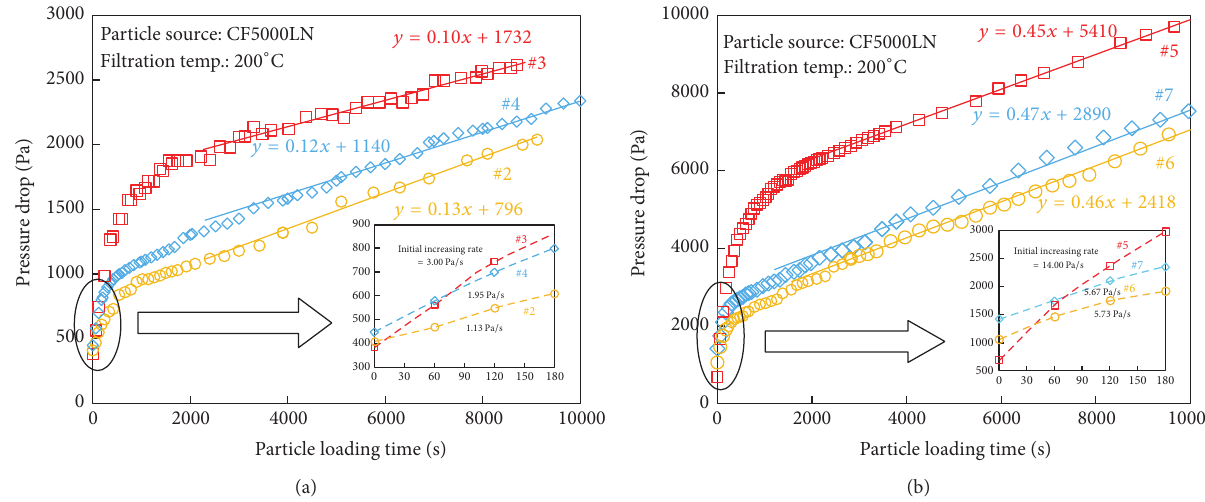
Figure 7: Pressure drop of different pore structure pieces: (a) filtration velocity = 0.02 m/s and (b) 0.04m/s.